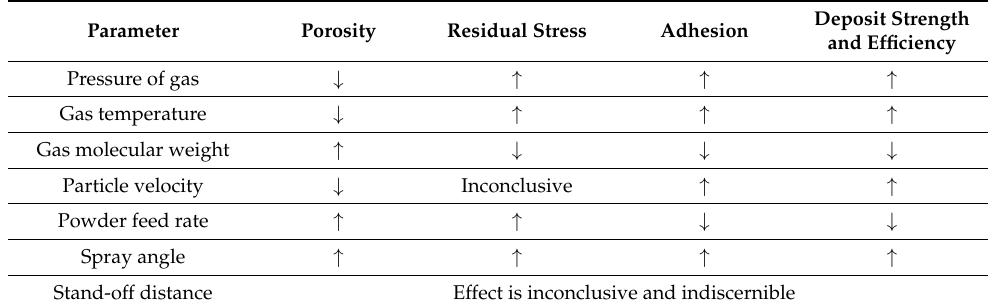
Table 2. Effects of the processing parameters on defects, adhesion, and deposition efficiency of cold spray